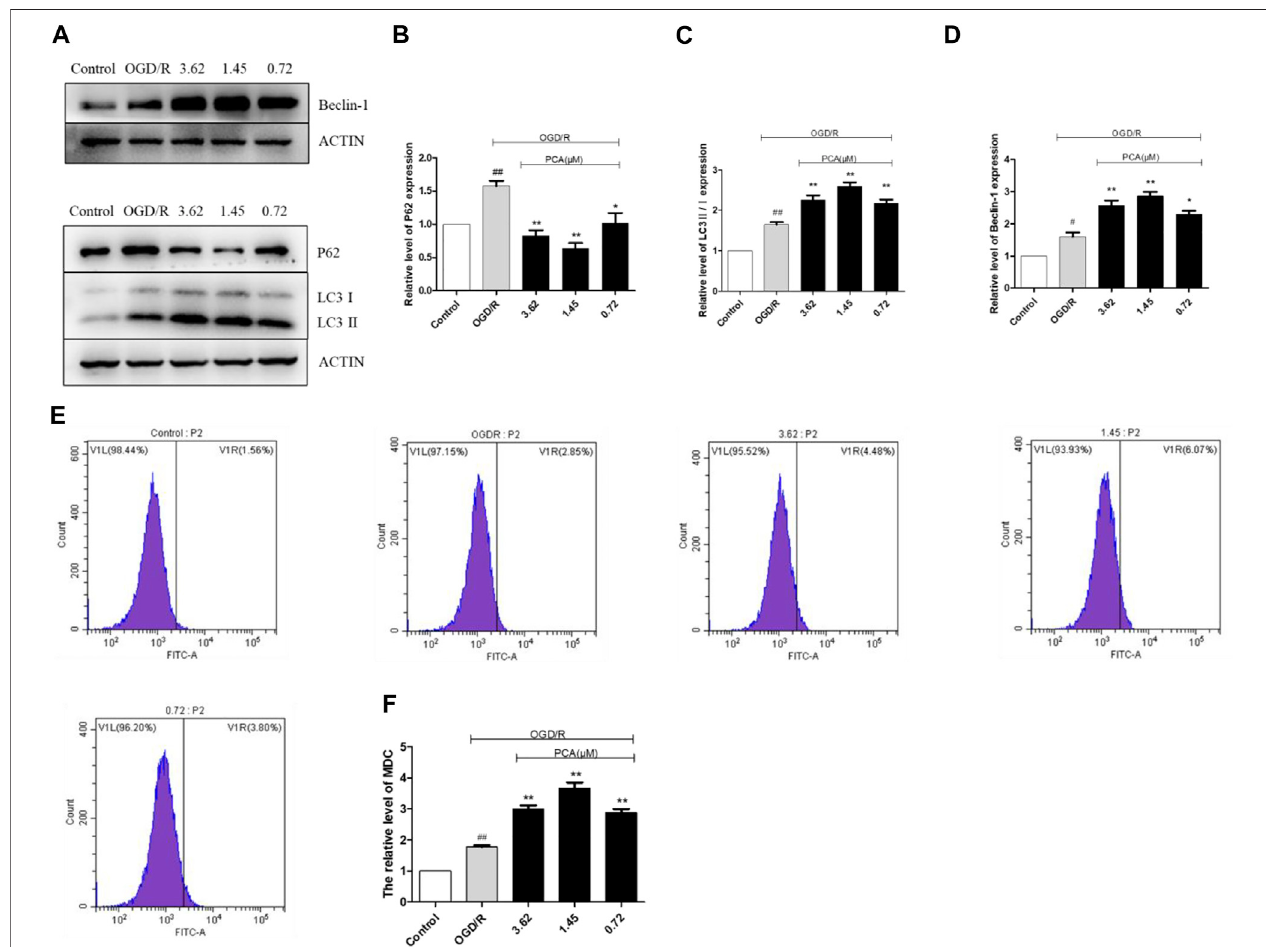
FIGURE5| PCAregulatedHUVECsautophagy. (A – D) RepresentativeimagesofWBanalysisandthesemi-quanti fi cationofP62,Beclin-1andLC3inHUVECs. (E, F) Representativeimagesof fl owcytometryanalysisofPCA in fl uenceand quanti fi cationofcellautophagy rate.Thevaluesareexpressed asthemean±SD( n =3). ## p < 0.01, # p < 0.05 vs. Control, ** p < 0.01, * p < 0.05 vs.